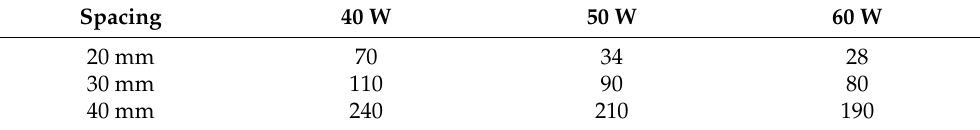
Table 4. Time for the coagulation zone fusion under different heating parameters (in seconds).